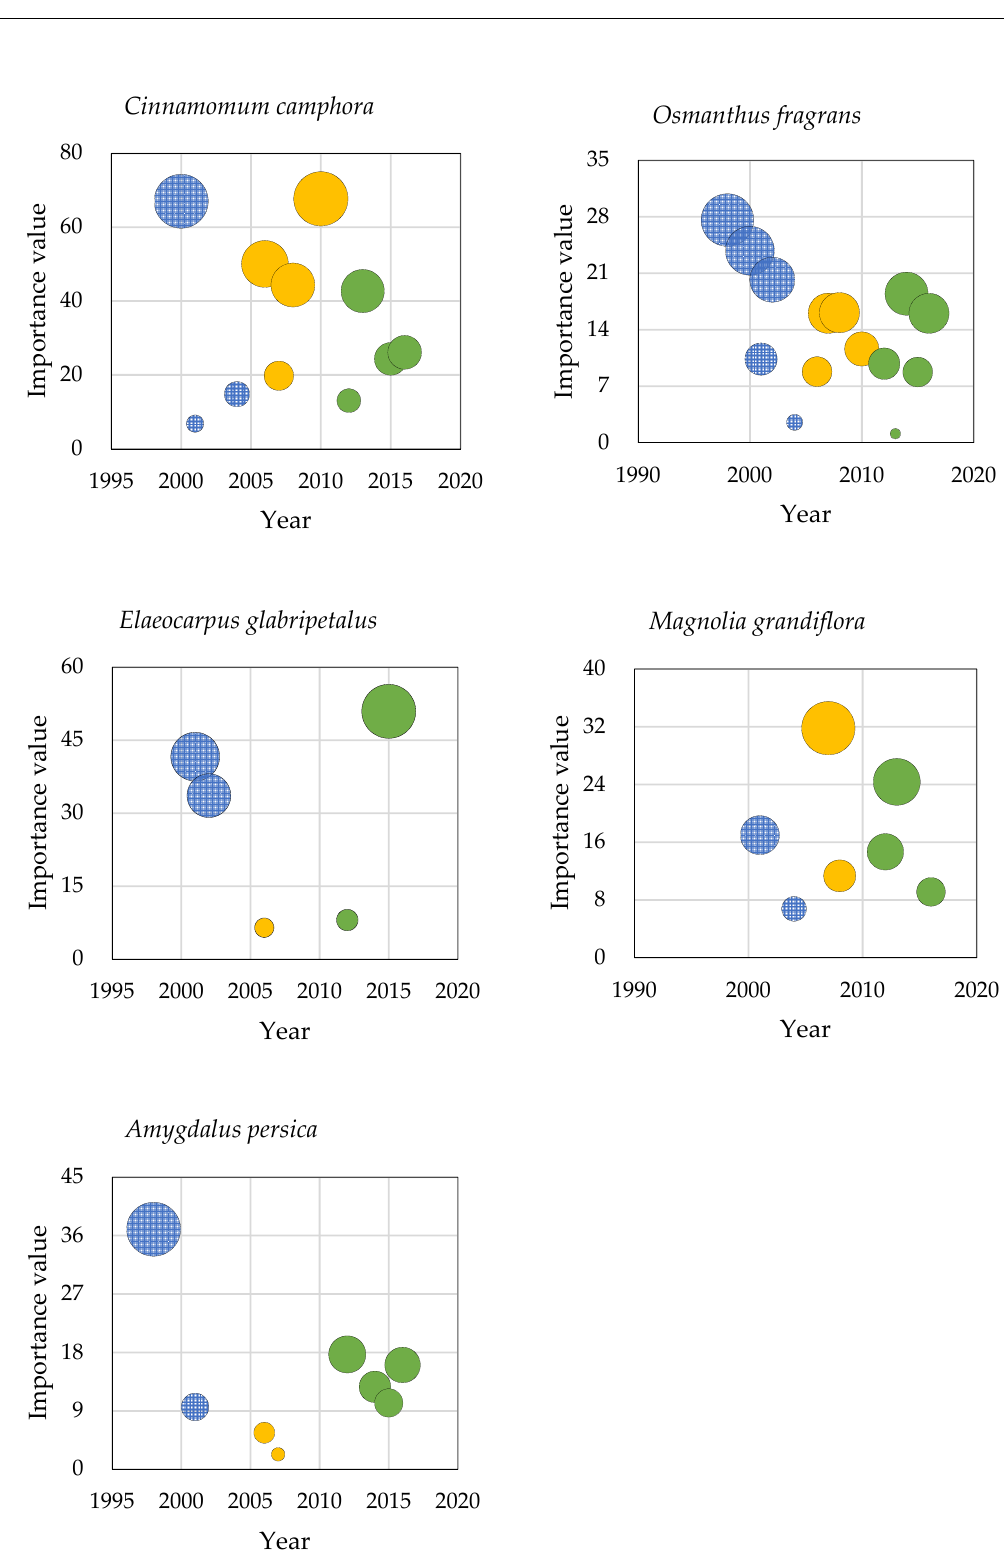
Figure 5. Distribution of importance values of five dominant tree species from 1998 to 2016 in the resettlement residential areas (RRAs) of Changzhou. In the graphs, the blue, yellow, and green circles represent chronological Groups A, B, and C RRAs in Changzhou from early to recent periods, as explained in Table 1. The circle size denotes the magnitude of the importance value.